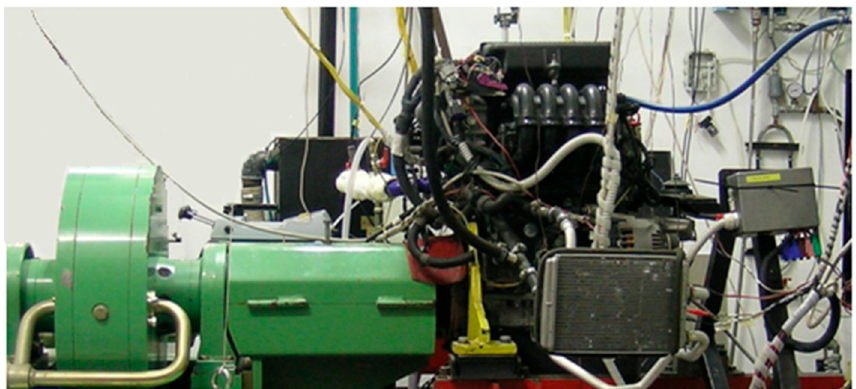
Figure 4. Experimental test rig for the 1.2 dm 3 engine.